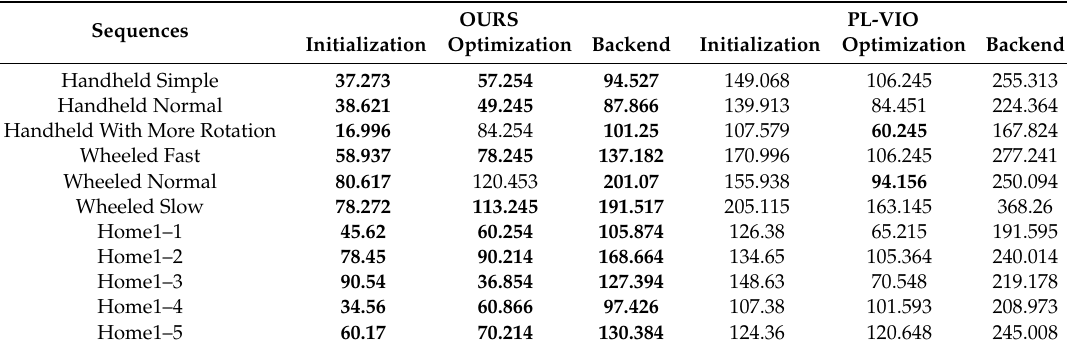
Table 4. Execution time of the whole backend in